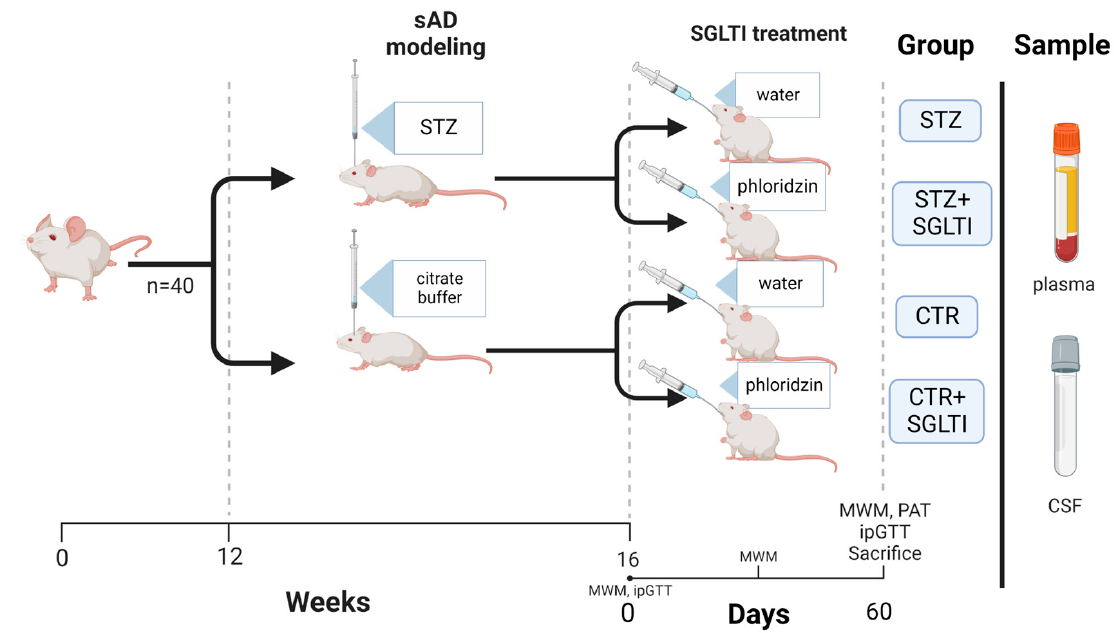
Figure 1. Experimental design. sAD—sporadic Alzheimer’s disease; STZ—streptozotocin group; SGLTI—sodium–glucose co-transporter inhibitor; MWM—Morris water maze test; PAT—passive avoidance test; CTR—control group; ipGTT—intraperitoneal glucose tolerance test; CSF—cerebrospinal fluid. Created with BioRender.com.